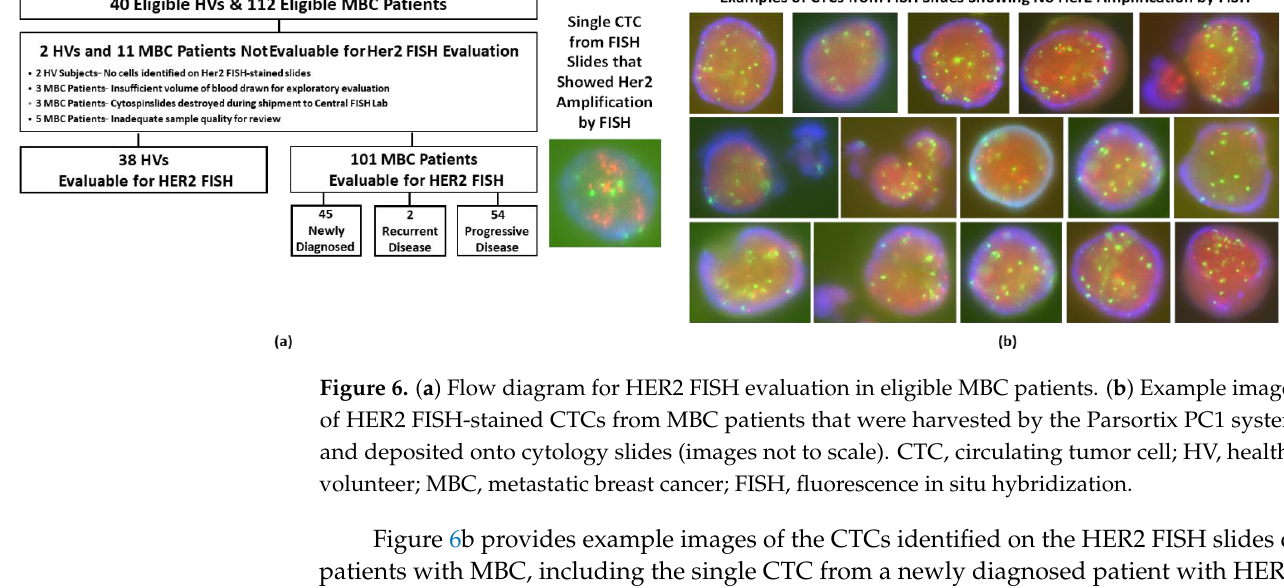
Table 5. Results from evaluation of Parsortix harvests using HER2 FISH. The number and propor- tion of samples with CTCs identified on the FISH slide and the number and proportion of samples showing CTCs with HER2 amplification in the HV subjects and MBC patients by their tissue HER2 status. Parameter and Categories